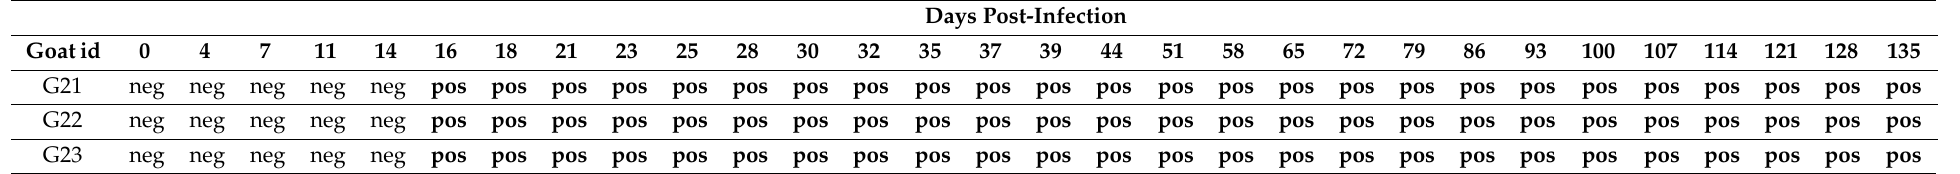
Table 3. cELISA results of the three goats intravenously infected with BTV-X (Trial 2). Day post-infection 11 was the first day BTV-X RNA was detected in goats. No animals showed detectable neutralizing antibodies as measured by